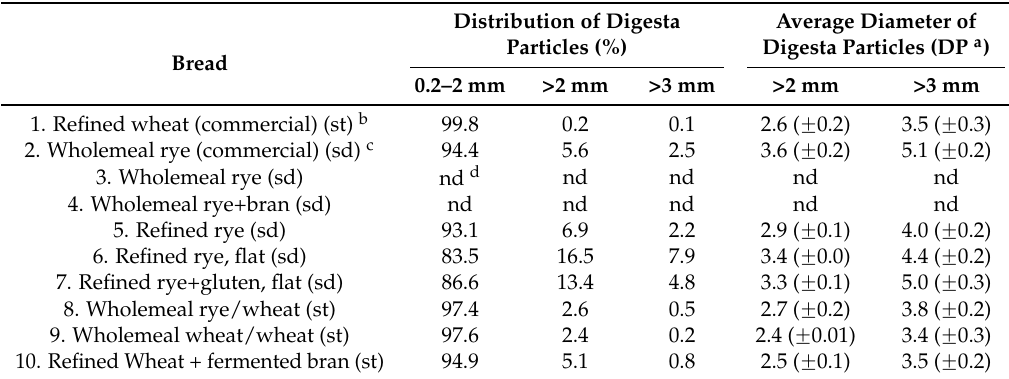
Figure 2. Micrographs of the residues after chewing in mouth: ( a ) wheat straight dough bread (Bread 1); and ( b ) whole meal rye sourdough bread (Bread 2). Micrographs of the residues after incubation with pepsin: ( c ) wheat straight dough bread (Bread 1); and ( d ) whole meal rye sourdough bread (Bread 2). Table 2. Particle size distribution (%) of the test breads after in vitro digestion of bread pieces (bread amount dosed based on 1 g potentially available carbohydrates).